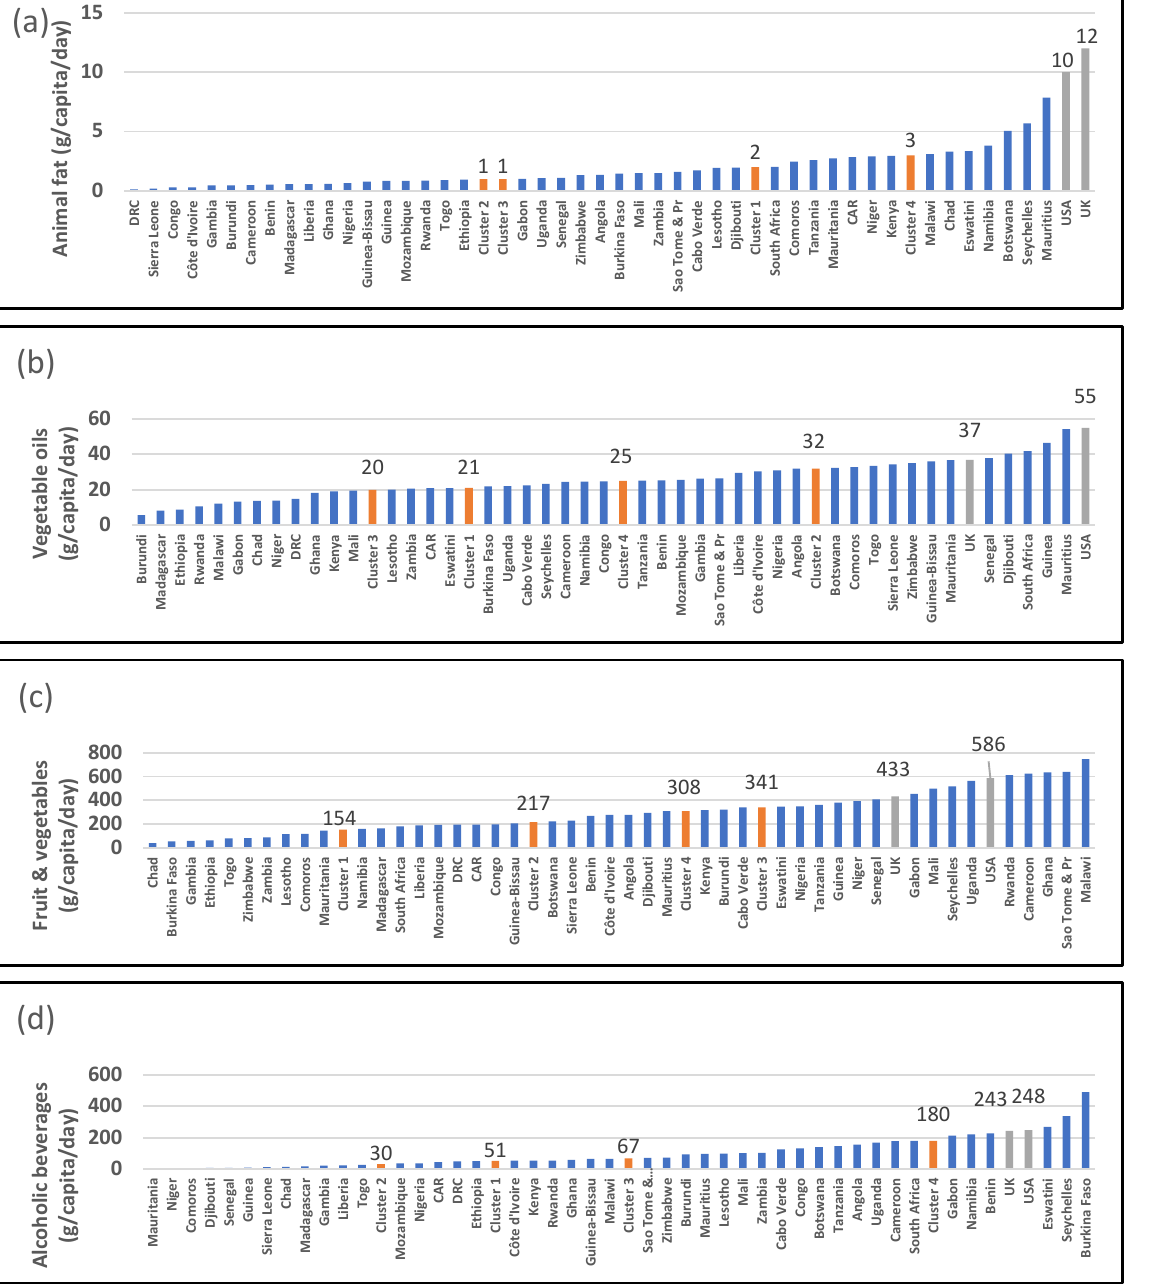
Figure 4. Data from food balance sheets for 2019 indicating per gram per capita intake per day for ( a ) vegetable oil, ( b ) animal fat, ( c ) fruit and vegetables, and ( d ) alcohol. Red columns indicate medians of clusters; source: